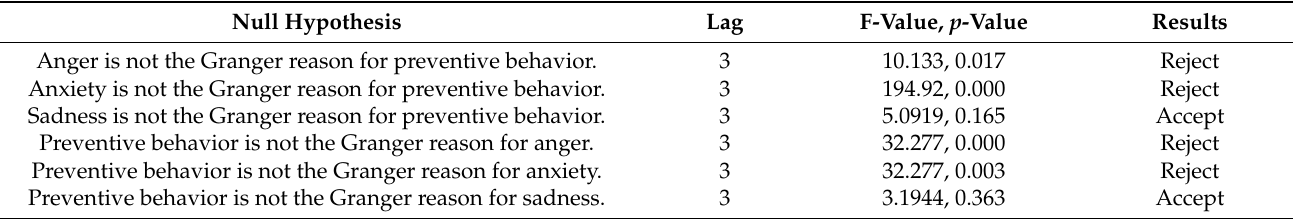
Table 6. Results of Granger causality tests between emotions and preventive behavior in the US.